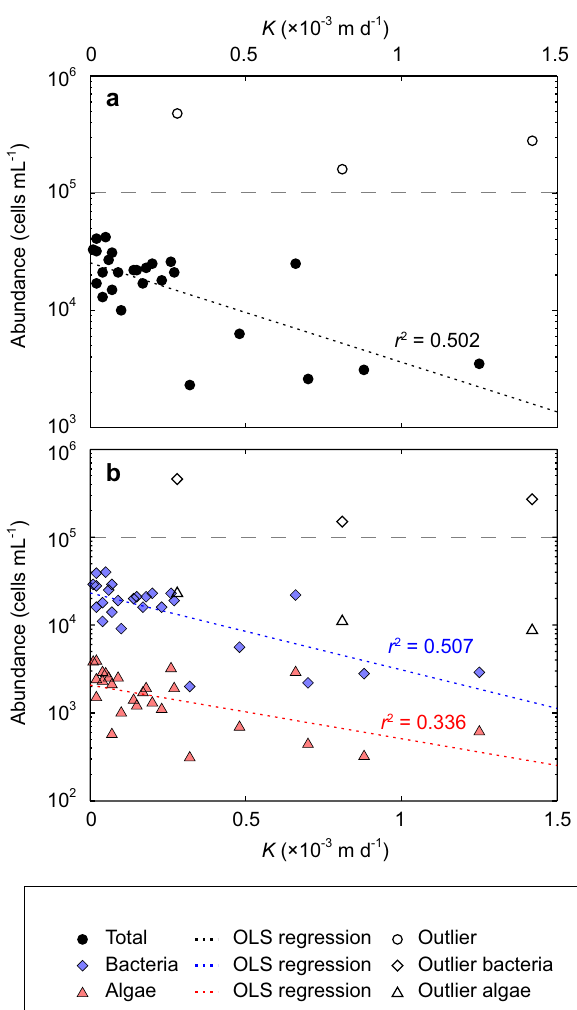
Fig. 5 Relationships between microbial abundance and hydraulic conductivity ( K ). a Scatter plot of hydraulic conductivity ( K ) and total microbial abundance for n = 29 successful, independent recharge experiments showing ordinary least squares (OLS) exponential regression relationship and coef fi cient of determination ( r 2 ) excluding the outlying samples ( n = 3) with >1 × 10 5 cells mL − 1 (see Methods) shown with hollowed markers above a dashed line. b Scatter plot, as in a , of K against abundance for the size-de fi ned bacterial and algal classes, again indicating the non-linear OLS regression line and r 2 , and outlying samples indicated with hollow